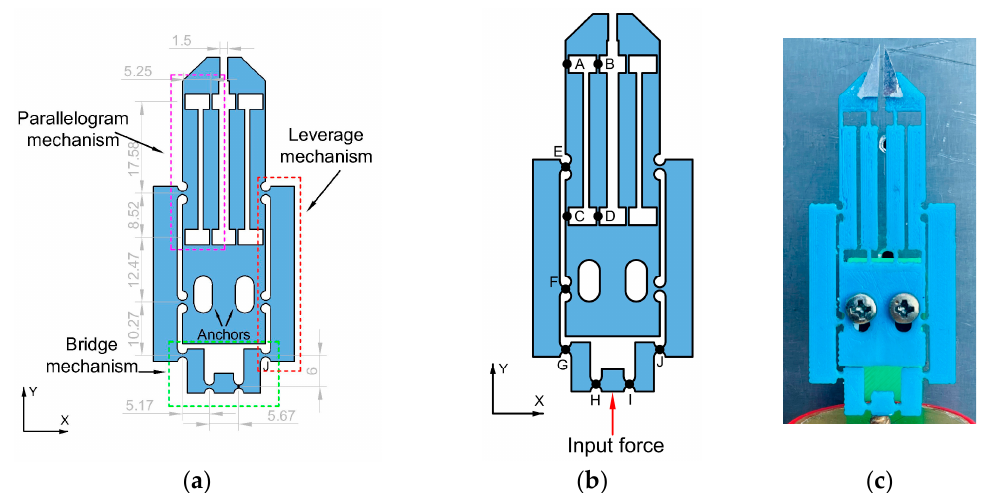
Figure 1. ( a ) Schematic diagram of MG based on compliance mechanisms. Dimensions are in millimeters. ( b ) Schematic diagram for functional description. ( c ) Photograph of the MG with metal tips added, with the initial aperture adjusted to achieve a final aperture of 1.5 mm, enough to perform practical tests.